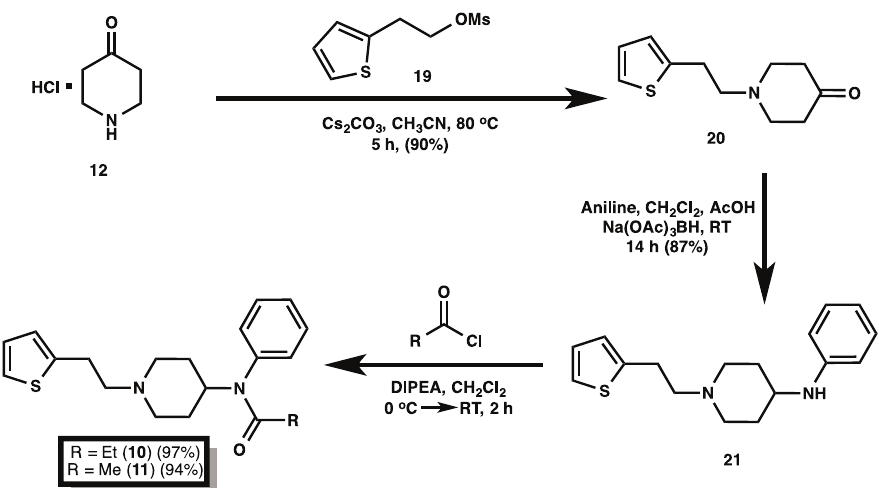
Figure 5. Synthesis of thiofentanyl and acetylthiofentanyl. Yields reflect the isolated materials by column chromatography after each step and using the optimized conditions (cf. Table 1). Citrate and hydrochloride salts for each analog were obtained in nearly quantitative yields by treating the free bases at the end of these routes with the corresponding acids.